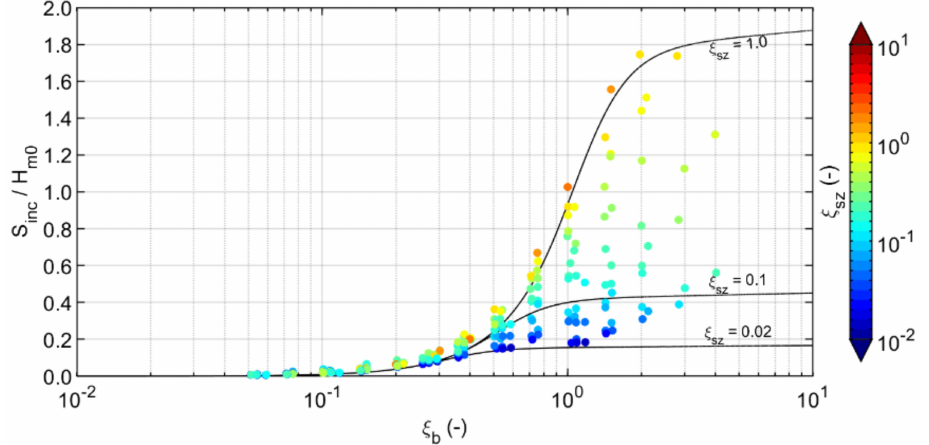
Figure 5. Relative incident run-up S inc / H m 0 as a function of ξ s and ξ b . Solid lines are the empirical fit for ξ sz = 0.02, ξ sz = 0.10, and ξ sz = 1.0.